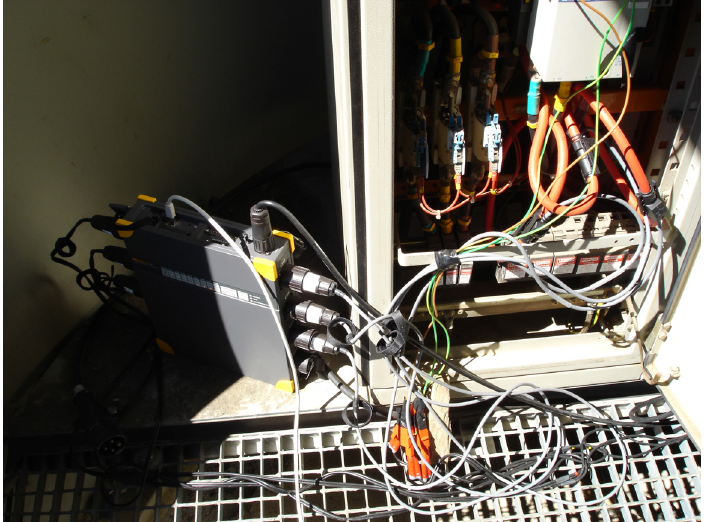
Figure 5. Connection of the Fluke 1760 three-phase power quality recorder.